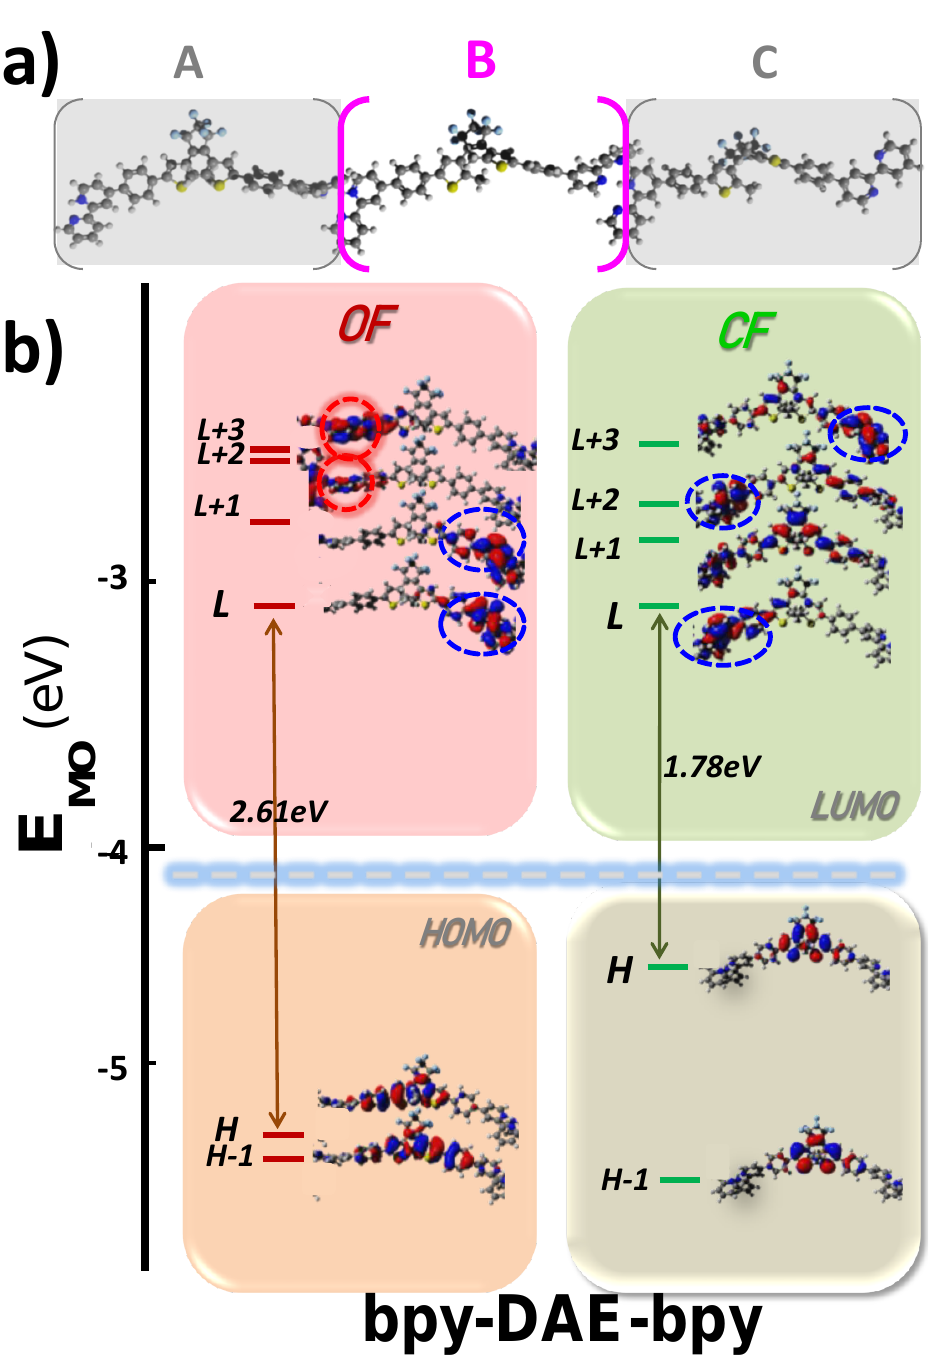
Figure 5. ( a ) DFT calculation for protonated bpy-DAE-bpy trimers, marked as A, B and C. ( b ) Frontier MOs of CF and OF from the B molecule in ( a ) are shown at different energy levels. Blue and red dashed circles highlight the enhanced orbitals from either the bipyridine or the phenyl-DAE-phenyl units, respectively. E F is here defined from the known HOPG Fermi level [84]. For the LUMOs, the CF bpy-DAE-bpy isomers have a low band gap around 1.78 eV and yield the frontier orbitals located on both the protonated left (LUMO and L + 2) and the neutral right bipyridine sites (L + 3). The OF isomers appear to be different, and have